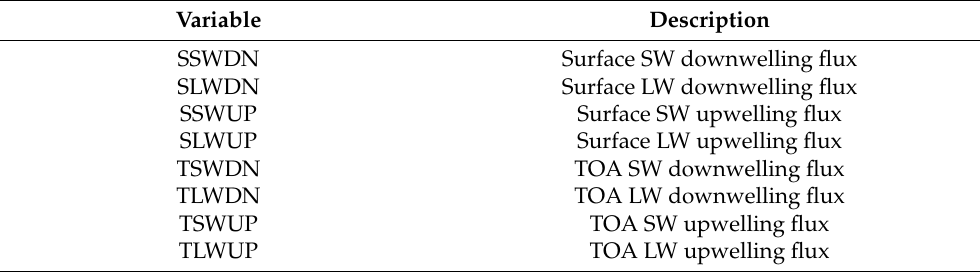
Table 7. WRF state variables for Goddard longwave (LW) and shortwave (SW) radiation at the surface and the top of the atmosphere (TOA); units are W m − 2 .